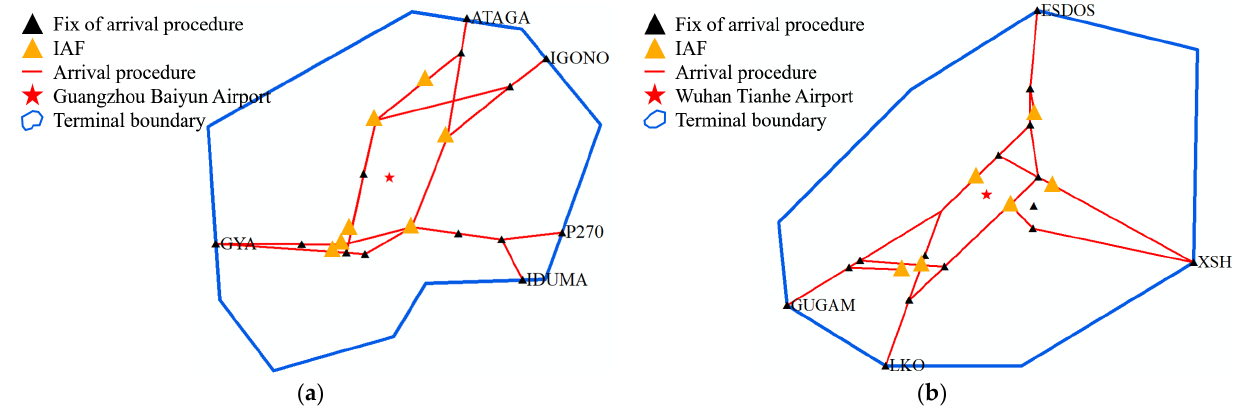
Figure 6. Airspace structure. ( a ) ZGGG, ( b ) ZHHH.